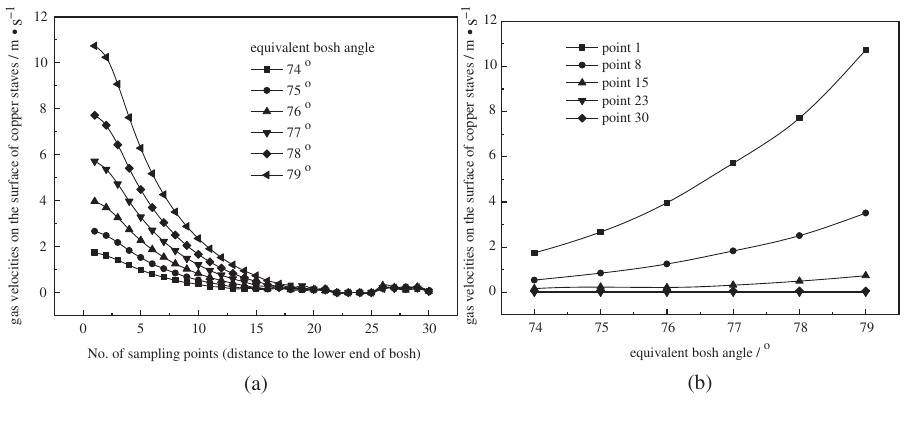
Figure 8: The gas flow velocities at the Bosh area before “ recti- fying effect ” under the condi- tions of different equivalent